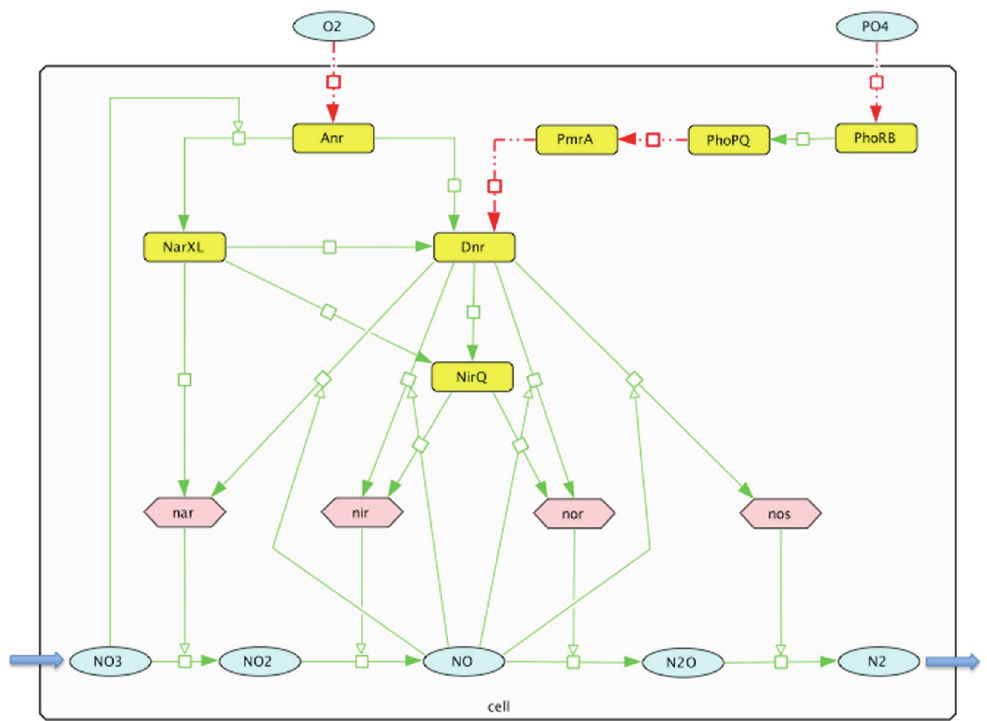
Fig 1. Denitrification regulatory network of P. aeruginosa . Green solid arrows indicate upregulation and red dashed arrows indicate downregulation. Model components are PhoPQ, PmrA, Anr, NarXL, Dnr, NirQ, nar , nir , nor , nos , NO 2 , NO , N 2 O , and N 2 . Our interest lies in perturbation of the external parameters ( O 2 , PO 4 , NO 3 ) and their effect on the long-term behavior of the network.